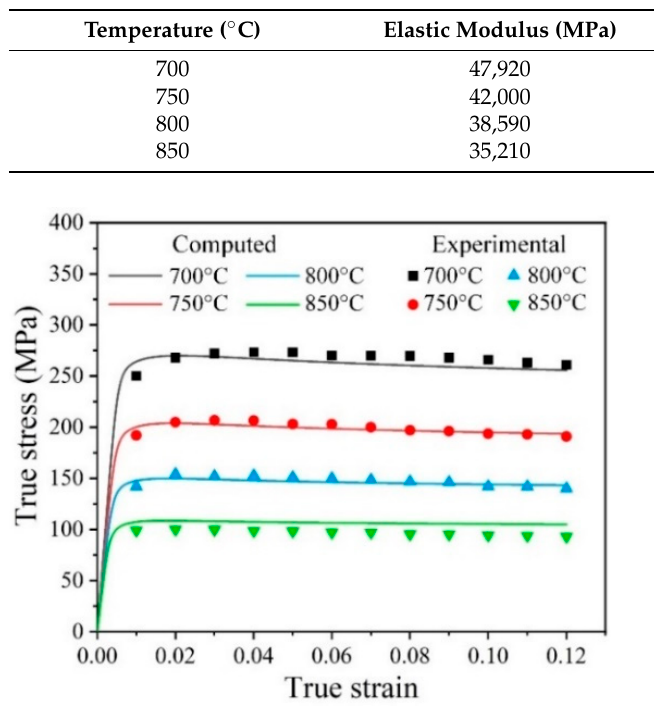
Table 2. Elastic modulus and yield strength calculated in tensile tests.